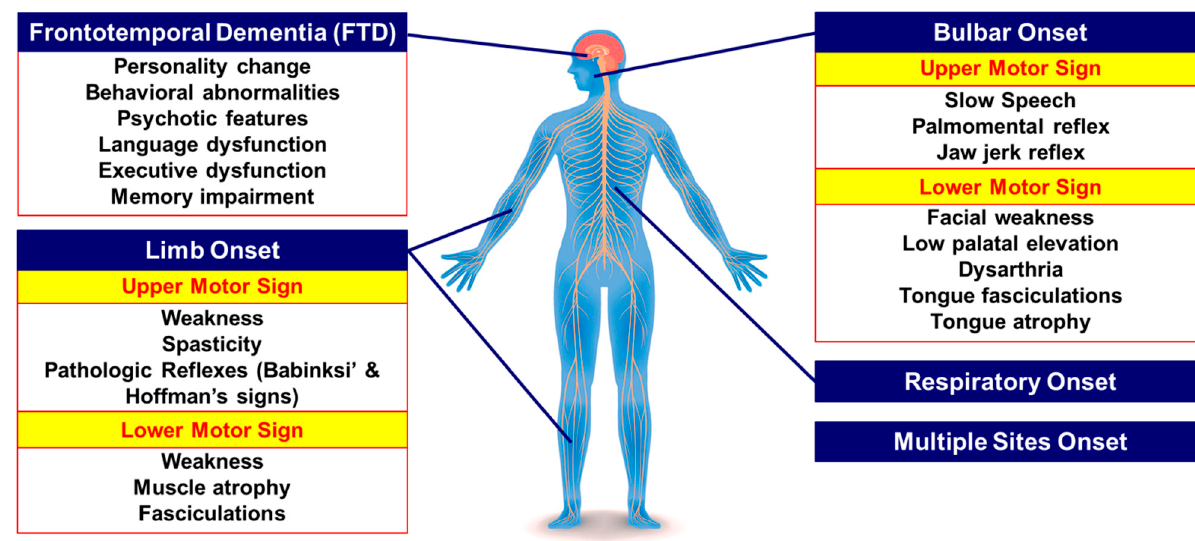
Figure 1. Clinical findings at onset in the chromosome 9 open reading frame 72 ( C9orf72 )-associated amyotrophic lateral sclerosis (ALS)/frontotemporal dementia (FTD).